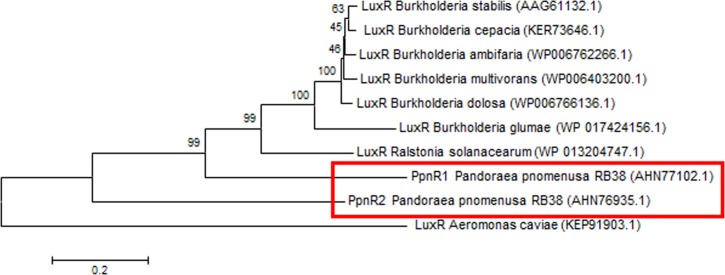
Phylogenetic tree of PpnR.Neighbor-Joining method (Saitou & Nei, 1987) was used in MEGA6 (Tamura et al., 2011) where bootstrap test (1,000 replicates) is shown next to the branches (Felsenstein, 1985).